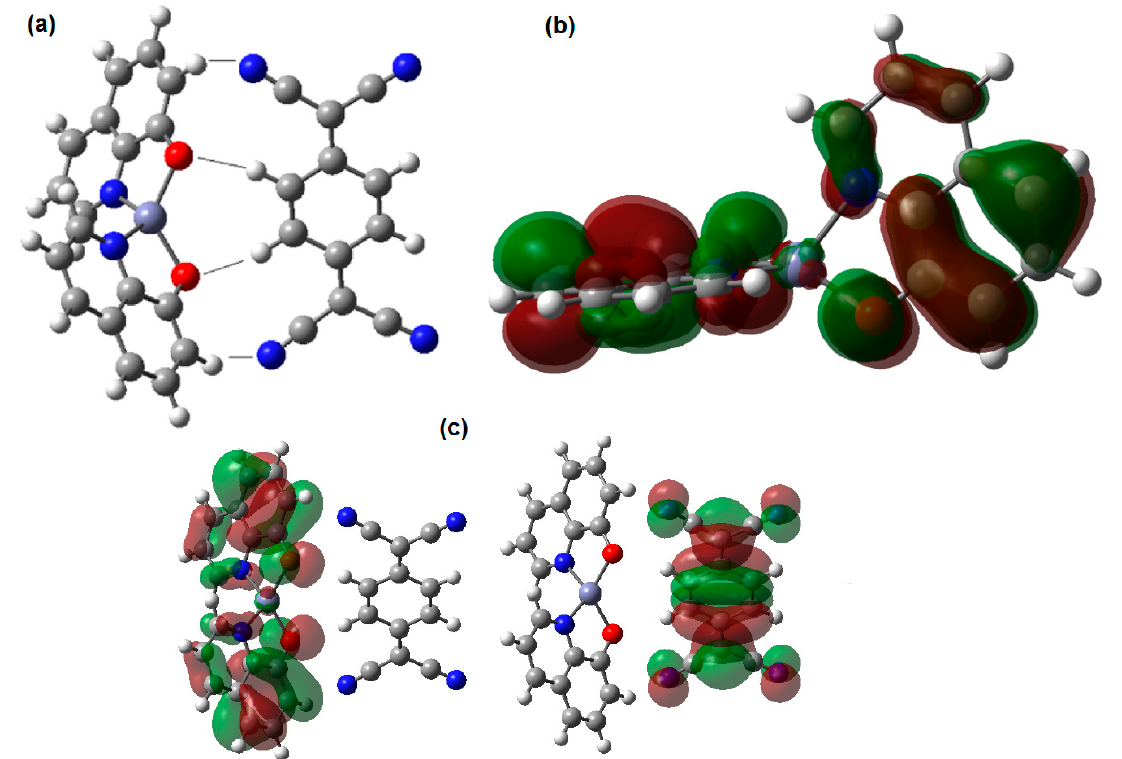
Figure 2. ZnQ 2 -TCNQ ( a ) optimized structure, ( b ) orbitals HOMO–LUMO of the formed complex, and ( c ) separated HOMO and LUMO functions. The last figures were taken from B3PW91/6-31G** calculations. Table 1. Energy values of orbitals HOMO and LUMO for compound ZnQ 2 -TCNQ and their pre- cursor compounds from B3PW91/3-31G**.